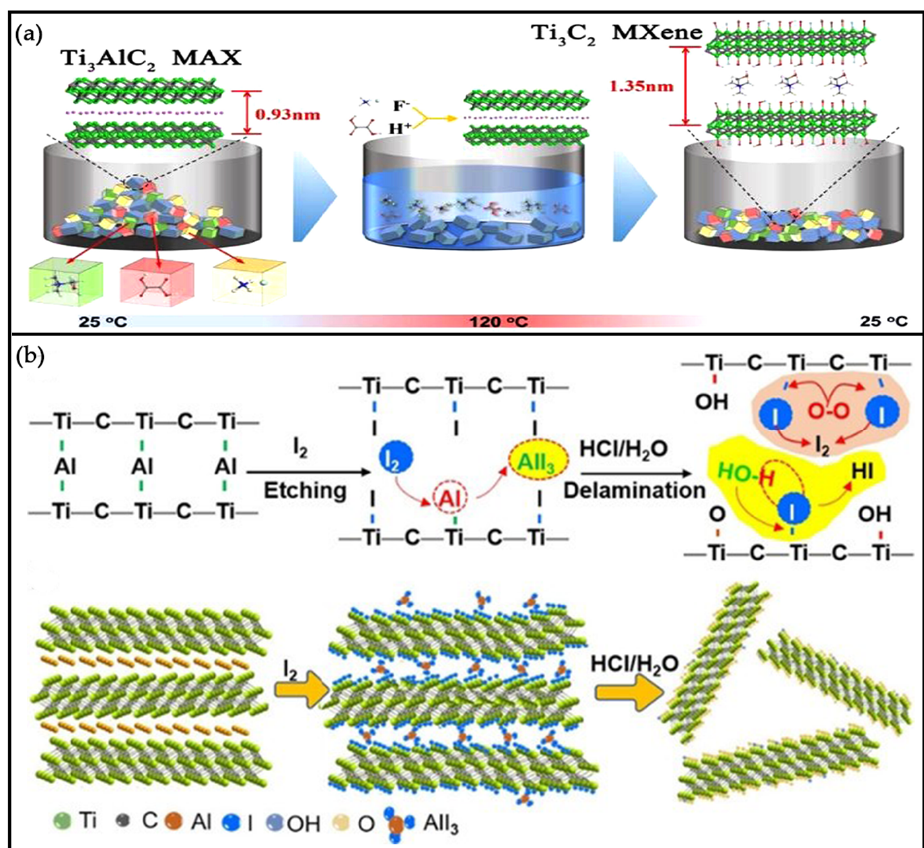
Figure 3. ( a ) Scheme of the ionothermal synthesis of DES-Ti 3 C 2 MXene. Reprinted with permission from Ref. [102]. Copyright 2019 Journal of Energy Chemistry . ( b ) The iodine-assisted etching and delamination of Ti 3 AlC 2 towards 2D MXene sheets. Reprinted with permission from Ref. [103]. Copyright 2021 Wiley-VCH GmbH.